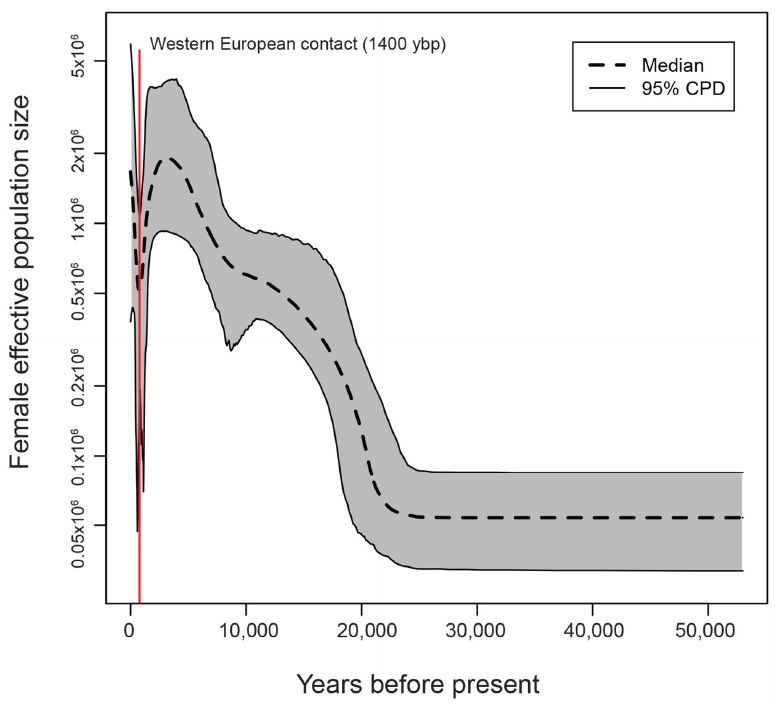
Figure 5. Demographic reconstruction of the UAE mitogenome. Extended Bayesian skyline plot of female effective population size and vertical red line to highlight the bottleneck event that is around 1400 ybp.